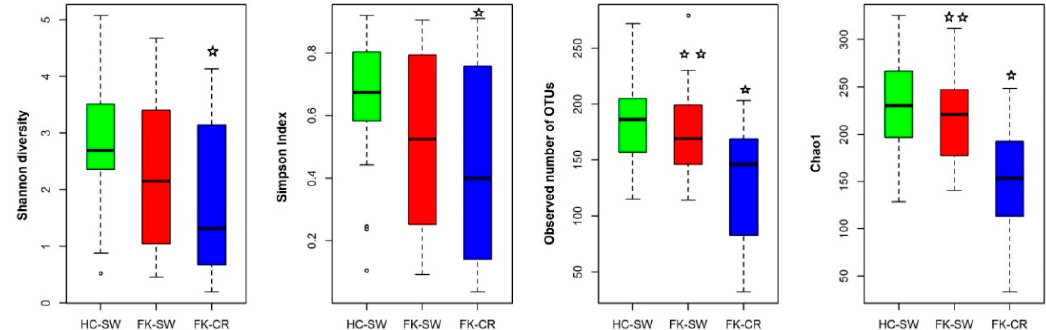
Figure 1. Alpha diversity indices of the ocular fungal microbiomes from conjunctival swabs of healthy controls (HC-SW, n = 37), conjunctival swabs of fungal keratitis patients (FK-SW, n = 23), and corneal scraping of fungal keratitis patients (FK-CR, n = 29). (cid:80) indicates significant di ff erence between HC-SW and FK-CR by Student’s t-test. (cid:80)(cid:80) indicates significant di ff erence between FK-SW and FK-CR by Student ′ s t-test.